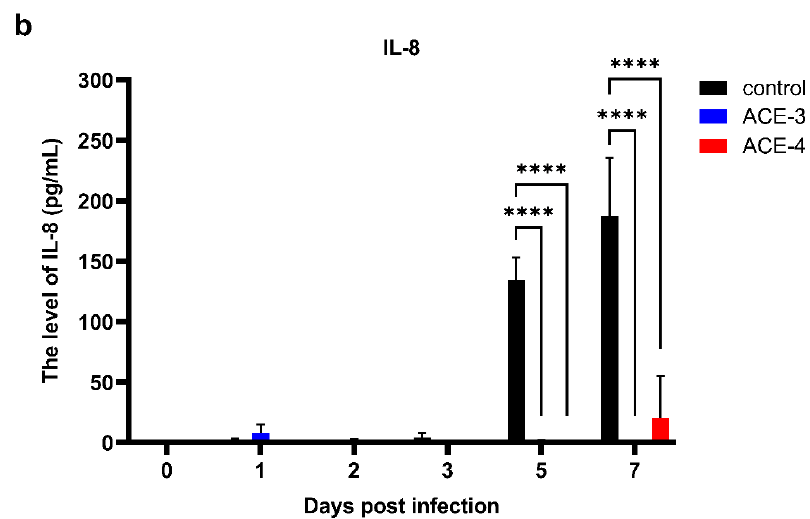
Figure 3. ACE-3 and ACE-4 suppressed the expression of the IL-6 and IL-8 after DENV infection. The levels of ( a ) IL-6 and ( b ) IL-8, in Meg-01 cells treated with the A. cinnamomea extracts after DENV infection. All the values represent as mean ± SEM of three experiments. p values were cal- culated using two-way ANOVA, p < 0.001 ***; p < 0.0001 **** compared to the control.